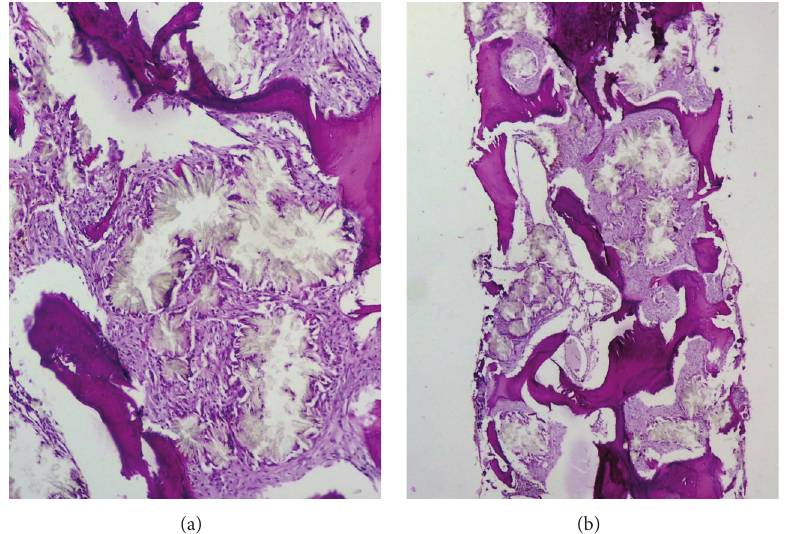
Figure 1: Extensive starburst crystal deposition in bone marrow, surrounded by foreign body giant cells and fibrosis. (a) × 400. (b) × 100.